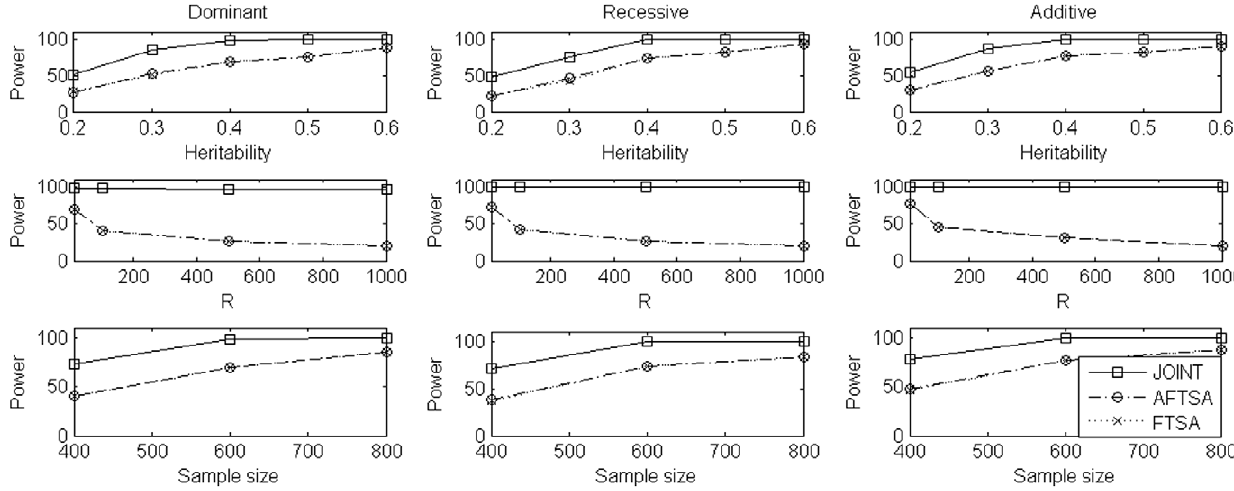
Figure 1. Power comparison under simulation set 1 when m =2. In the first row, we compare power of the three methods for different values of heritability under the three disease models while sample size is 600 trios and the number of markers selected at the first stage is 10. In the second row, we compare power of the three methods for different numbers of markers selected at the first stage under the three disease models while sample size is 600 trios and heritability is 0.05. In the third row, we compare power of the three methods for different sample sizes under the three disease models while heritability is 0.05 and the number of markers selected at the first stage is 10. In each case, we use 800 genomic markers to control for population stratification in the admixture screening test.